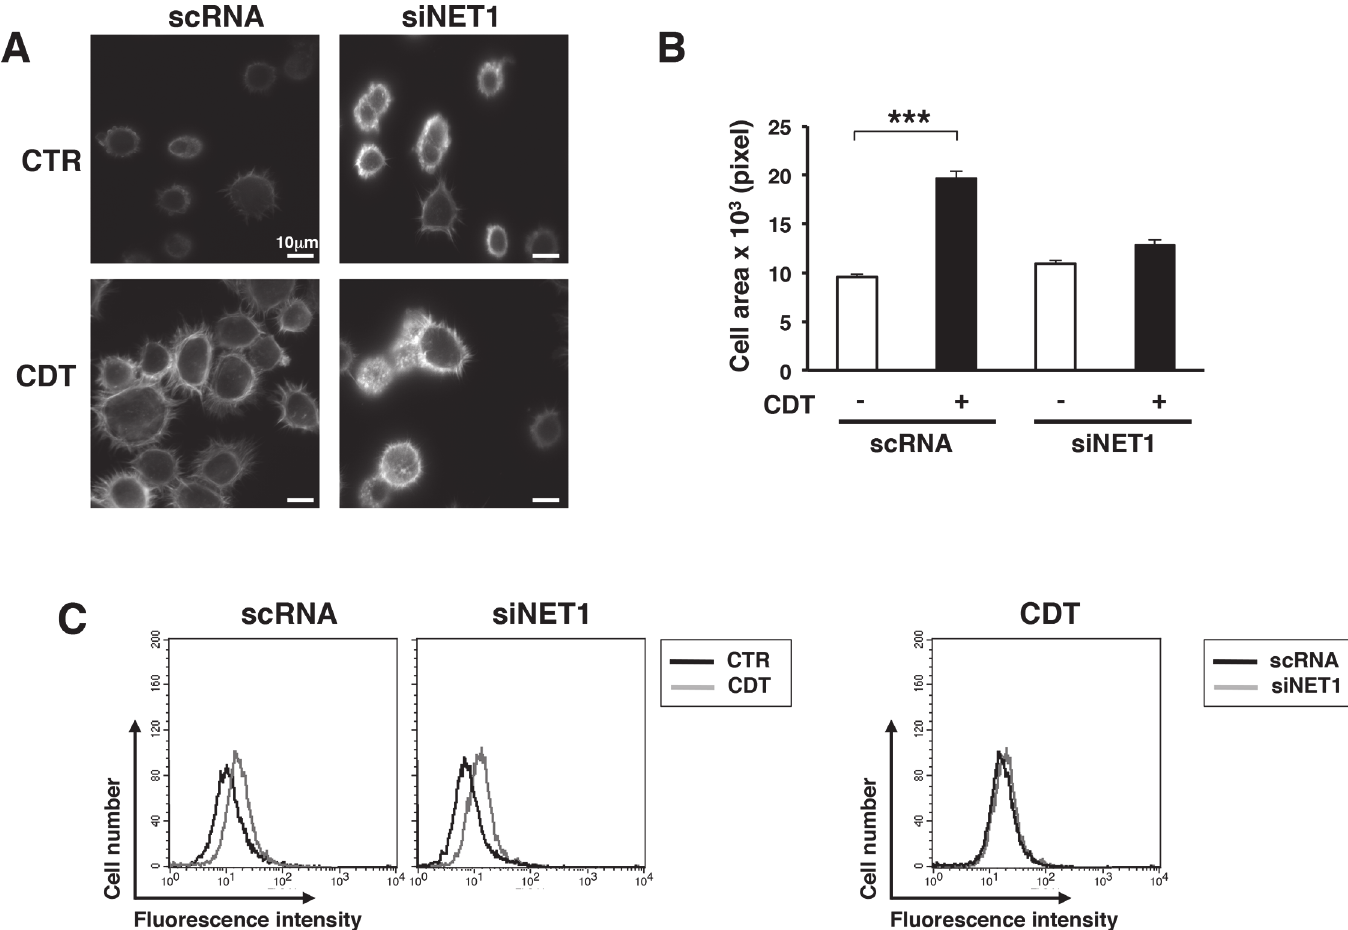
Fig 6. NET1 is required to promote cell spreading upon CDT intoxication. A. HeLa cells, transfected with the non-silencing siRNA (scRNA) or the NET1 specific siRNA (siNET1), were left untreated (CTR) or intoxicated with CDT (1 μ g/ml) for 6h, prior adhesion for 20 minutes on fibronectin-coated glasses. The figure shows representative micrographs where the actin cytoskeleton was visualized by phalloidin staining. B. The quantification of the cell area was performed as described in Fig 1. The data are presented as the mean ± SEM of three independent experiments. Statistical analysis was performed using